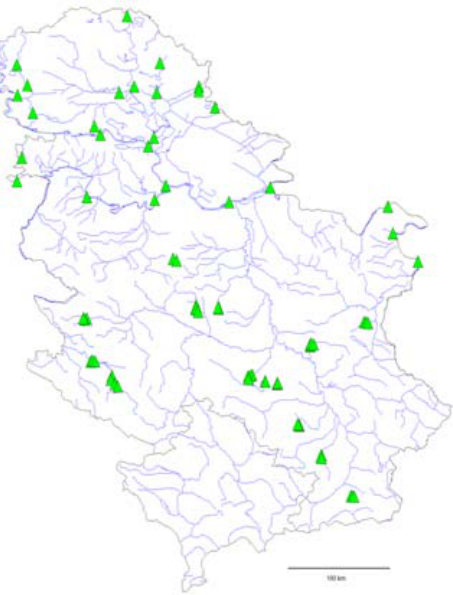
Figure 1. Map of surveyed altered waterbodies in Serbia.